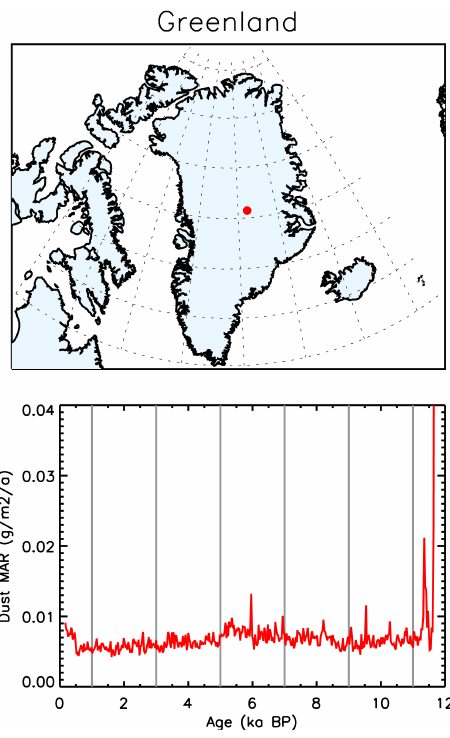
Figure 12. Same as Fig. 6 but for the equatorial